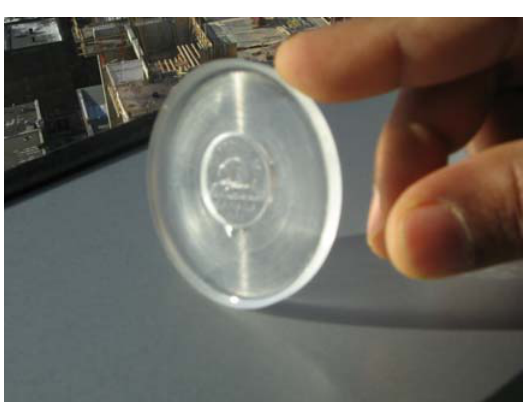
Figure 7. PDMS mould used to cast